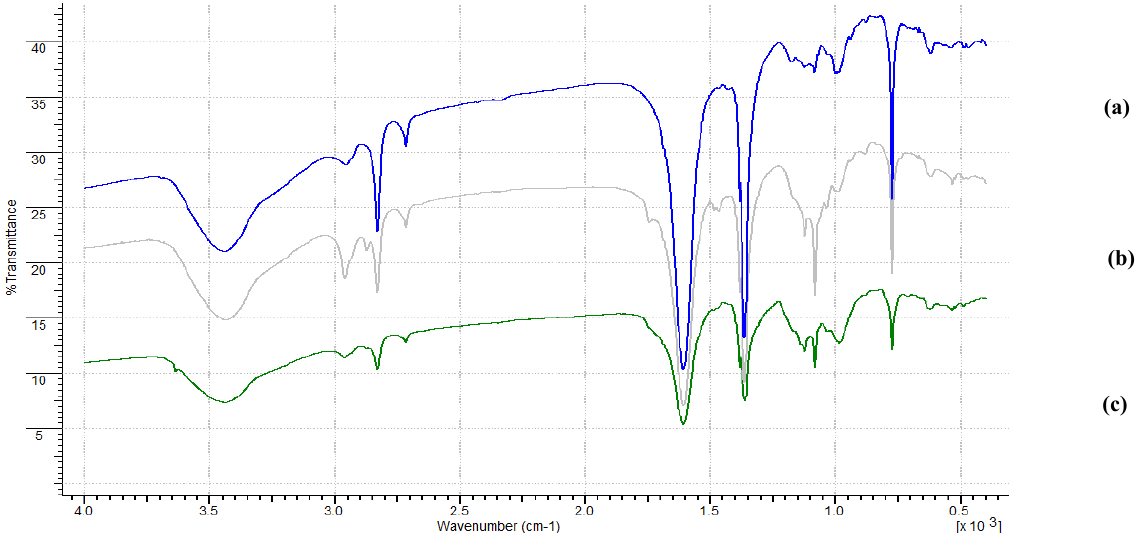
Figure 4. FTIR spectrum of the polythiophene SPME fiber before electrodesorption ( a ), after electrodesorption ( b ) and without imprinted drug molecule ( c ) (for CEF) (KBr pelleting technique).